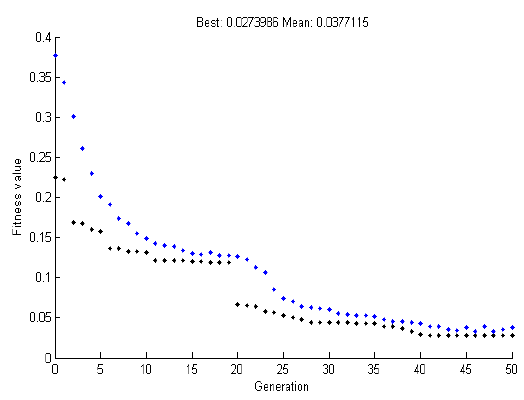
Figure (3)-Performance of GA runs for selecting best index of bands.